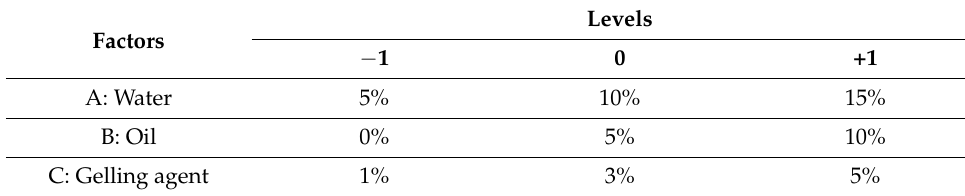
Table 2. Optimization table showing factors with their levels ( − 1, 0, and